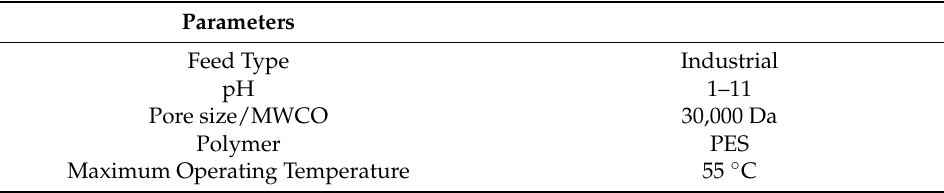
Table 2. UF membrane specification